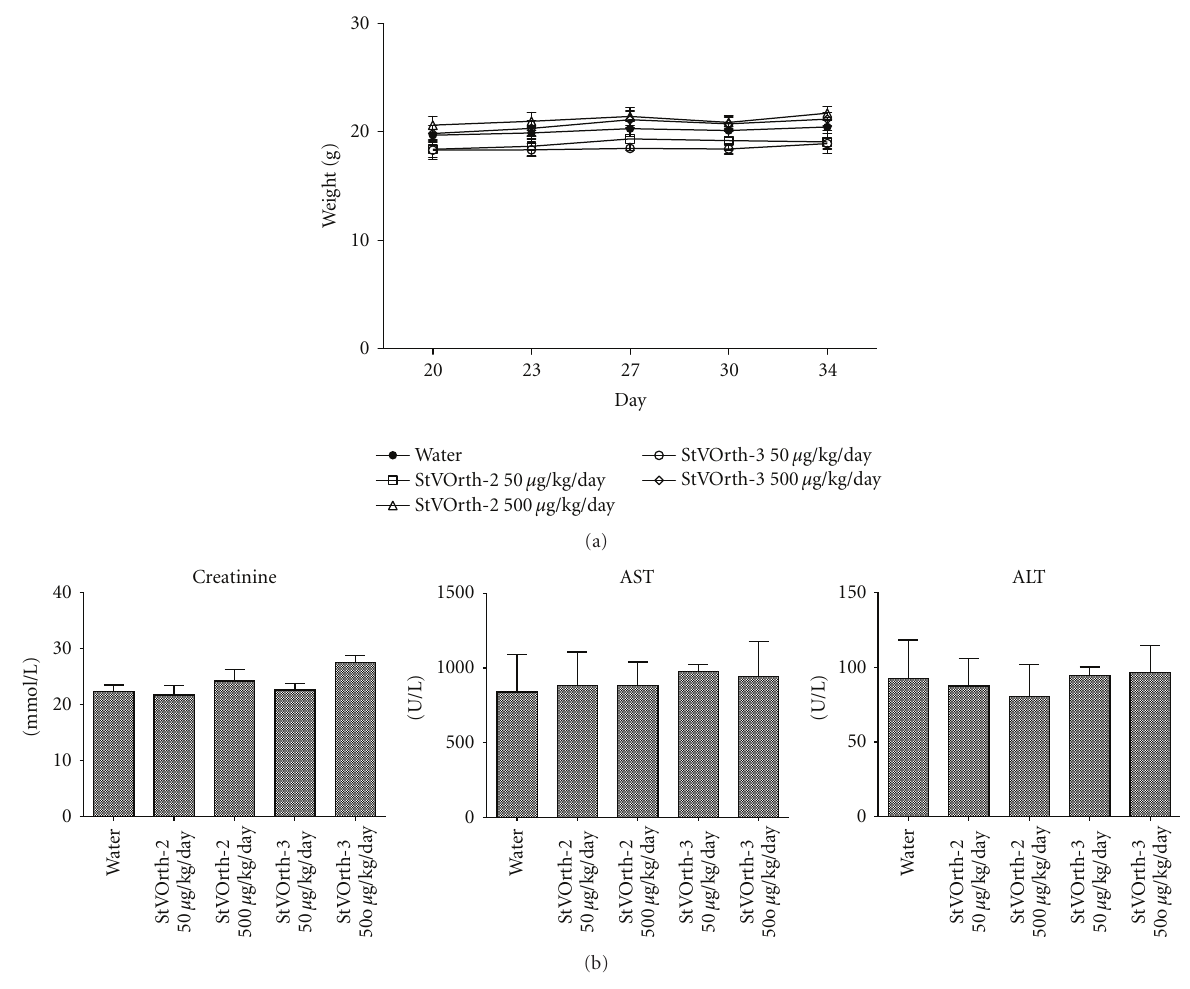
Figure 2: (a) Animal weights recorded at days 20, 23, 27, 30, and 34 after SaOS-2 intratibial injection. There was no significant weight loss compared to control. (b) Biochemical analysis of serum collected postmortem ( ± SEM). There was no evidence of renal or hepatic